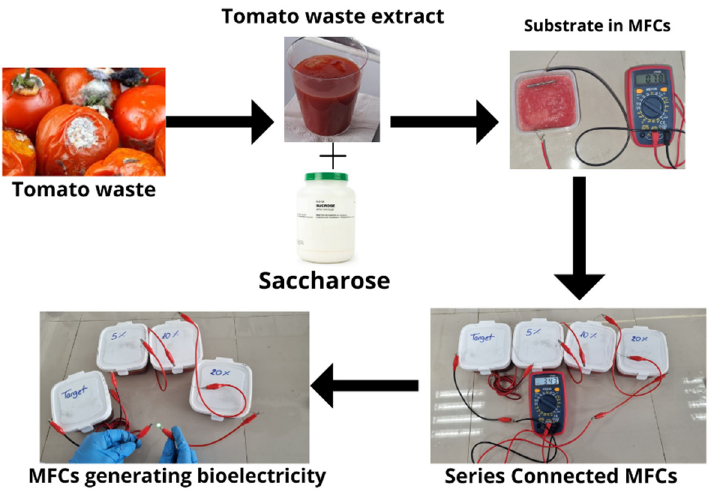
Figure 6. Generation of bioelectricity by